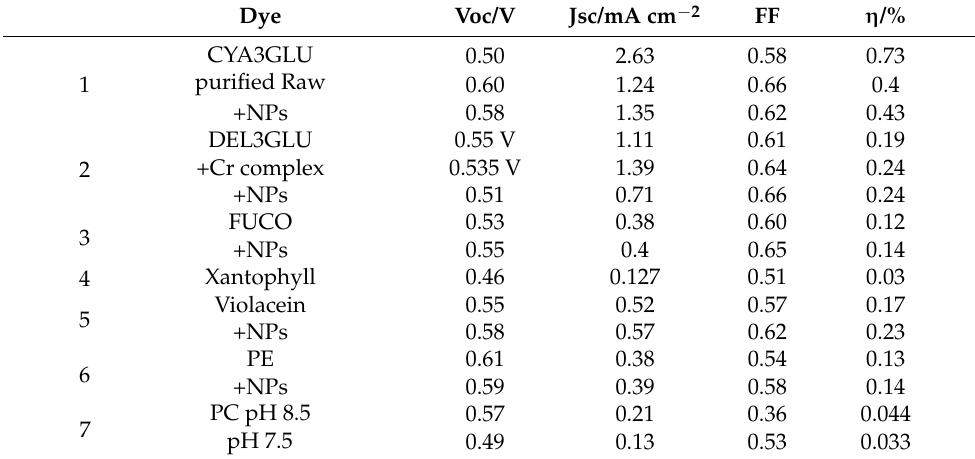
Table 1. Photovoltaic properties for cells assembled using different sensitizers. All measurements were performed under a light intensity of 1 sun, 100 mW cm − 2 , AM 1.5 G, and the active areas were 0.7 cm 2 for all the cells. Jsc is the current density, Voc is the open circuit potential, FF is the fill factor, and η is the conversion efficiency. Results arise from 5 independent experiments performed for each dye, with SD = 3 10 − 3 . Dye Voc/V Jsc/mA cm − 2 FF η /% CYA3GLU purified Raw